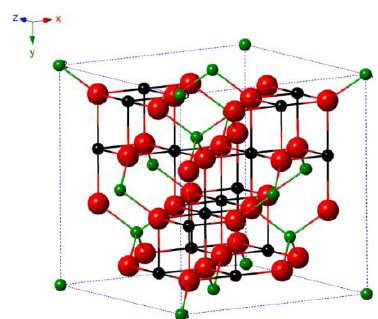
Figure 1. Crystal structure of magnetite (Fe 3 O 4 ). The green balls are ferric ions; the red balls are oxygen ions; and the black balls are ferrous ions [13]. [Reprinted with permission from Wu et al. [13]. Published 2015 by Taylor and Francis under the Creative Commons Attribution 3.0 (CC-BY-3.0) License].